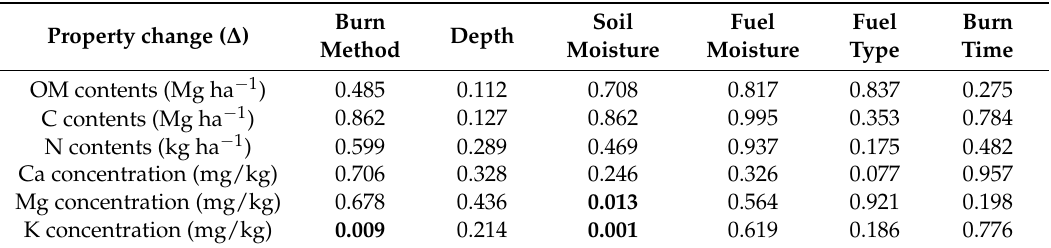
Table 4. Test results of analysis of variance for soil properties. Numbers represent the p -values and significant results were marked in bold fonts ( p < 0.05).